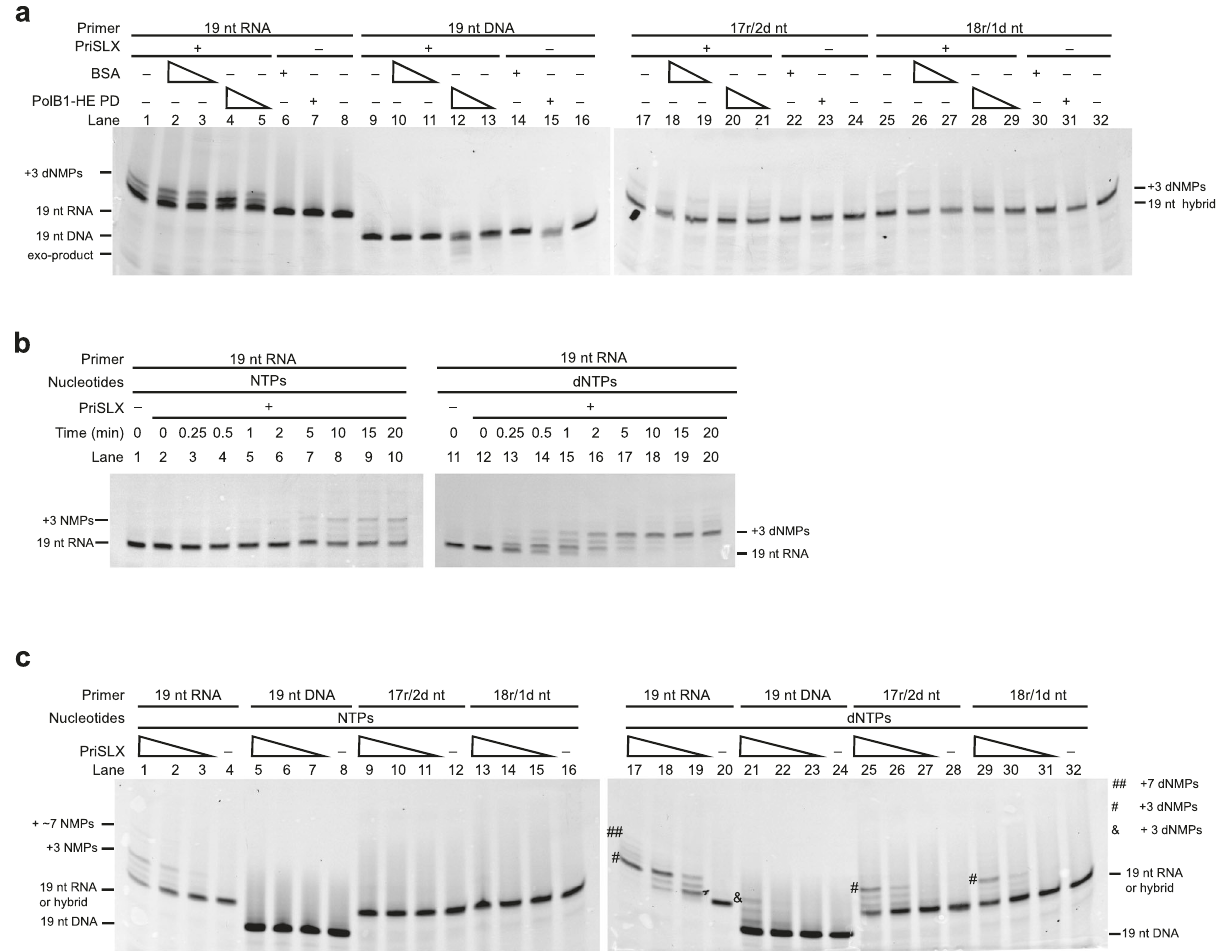
Fig. 4 PriSLX elongation activity. a Primer elongation reactions of 100 µ M dNTPs; 25 nM 5 ′ -cy5-labeled primer as indicated annealed to 80 nt template; 25 nM PriSLX as indicated; BSA titration (25, 12.5 nM) and control (25 nM) as indicated; and PolB1-HE PD (Polymerase Dead) titration (25, 12.5 nM) and control (25 nM) as indicated. Reactions were incubated for 5 min at 75 °C prior to termination and electrophoresis on denaturing polyacrylamide gels. Three independent replicates of this experiment were performed. b Primer elongation reactions of 100 µ M NTPs or dNTPs as indicated; 25 nM 5 ′ -cy5- labeled primer annealed to 80 nt template; and 25 nM PriSLX. Reaction times as indicated at 75 °C prior to termination and electrophoresis on denaturing polyacrylamide gels. Three independent replicates of this experiment were performed. c Primer elongation reactions of 100 µ M NTPs or dNTPs as indicated; 25 nM 5 ′ -cy5-labeled primer as indicated annealed to 80 nt template; and PriSLX titration (50, 25, 12.5 nM) as indicated. Reactions were incubated for 5 min at 75 °C prior to termination and electrophoresis on denaturing polyacrylamide gels. Four independent replicates of this experiment were